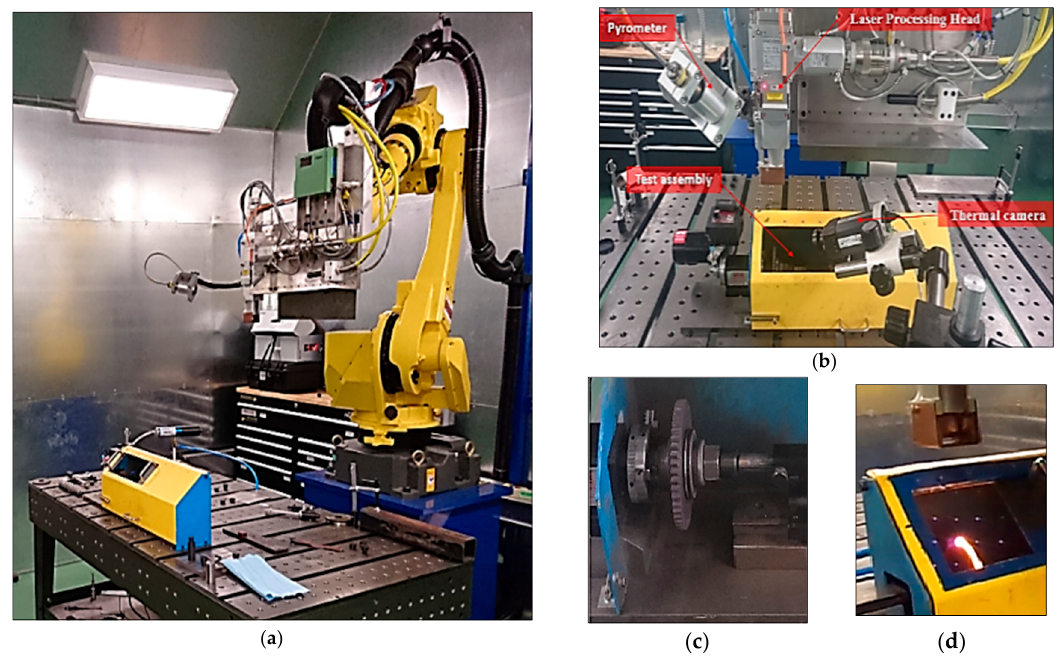
Figure 1. Experimental setup for gear laser surface transformation hardening (LSTH): ( a ) Overview of the LSTH cell, ( b ) major cell components, ( c ) gear assembly and ( d ) gear during the heating process.